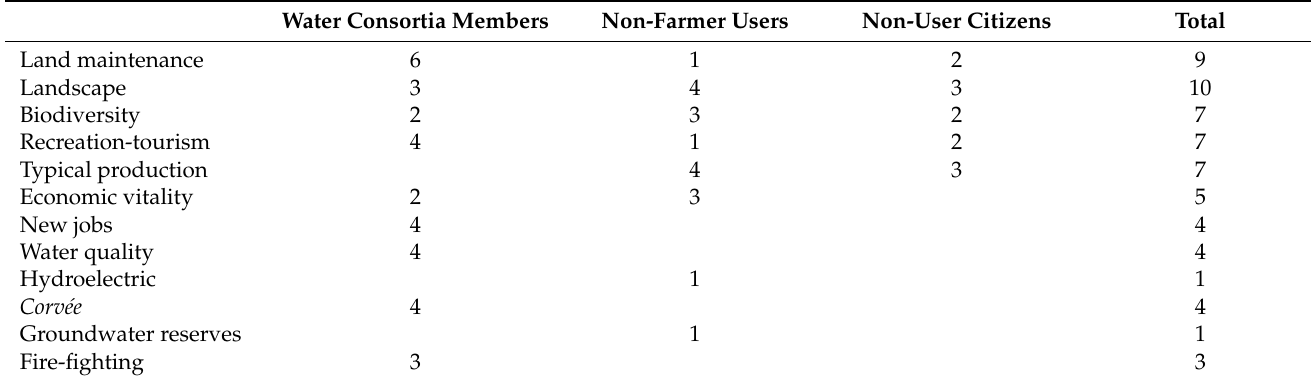
Table A2. Participants involved in the discussion